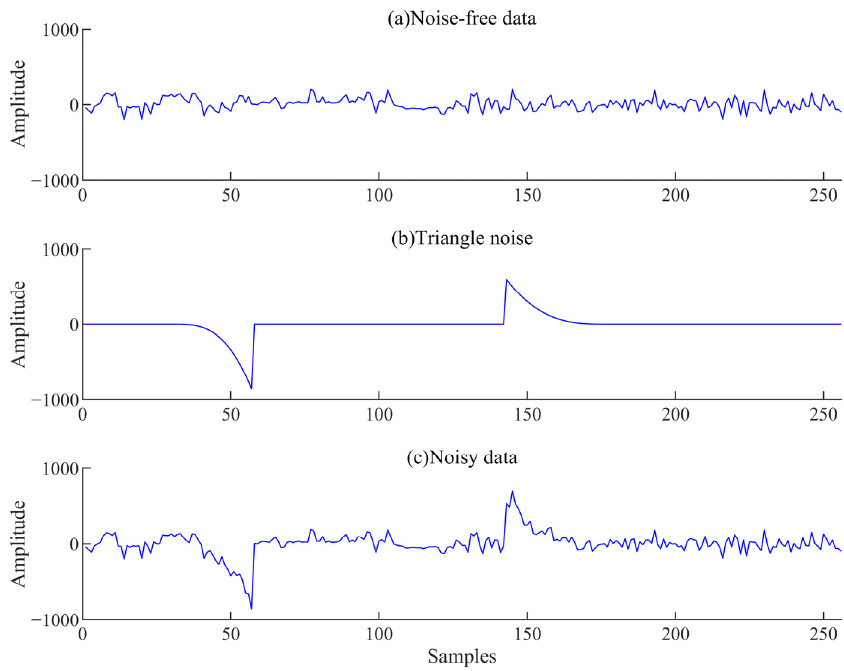
Figure 7. Synthesis of triangle noise. ( a ) Noise-free data, ( b ) triangle noise, ( c ) noisy data.